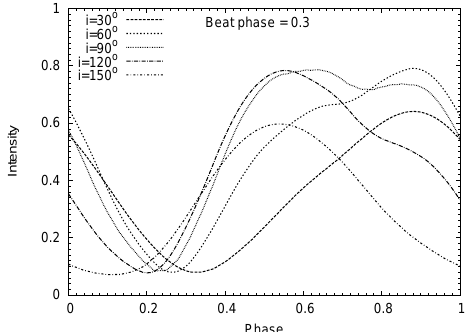
Figure 2: Synthetic light curves derived from a non- aligned dipole plus quadrupole field model at beat phase 0.3 are shown as an example. These light curves resem- ble some of the observed light curves of BY Cam, see Figure 1. Calculations of accretion flow patterns at 10 beat phases were performed. for pure dipole and dipole plus quadrupole field components of various dipole/quadrupole field strength ratios. Figures 2 and 3 show synthetic light curves of a BY Cam model at two beat phases.